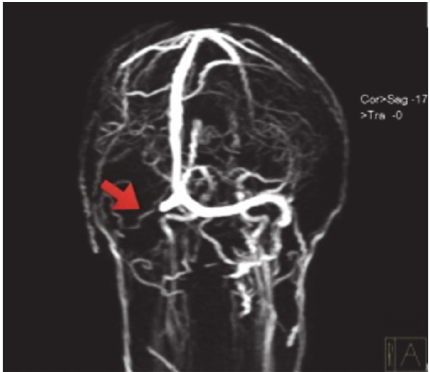
Figure 1: MRI venography showing right transverse and sigmoid sinus thrombosis